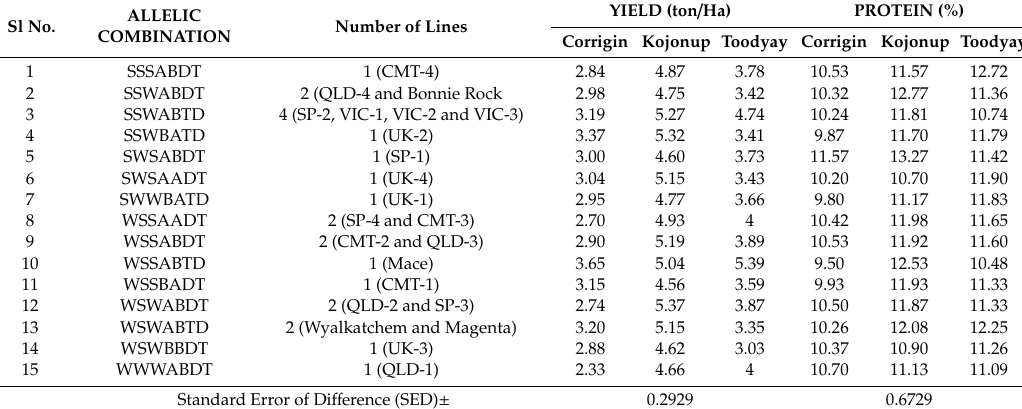
Table 3. Location and allelic combination interaction e ff ects on yield and protein content. Sl